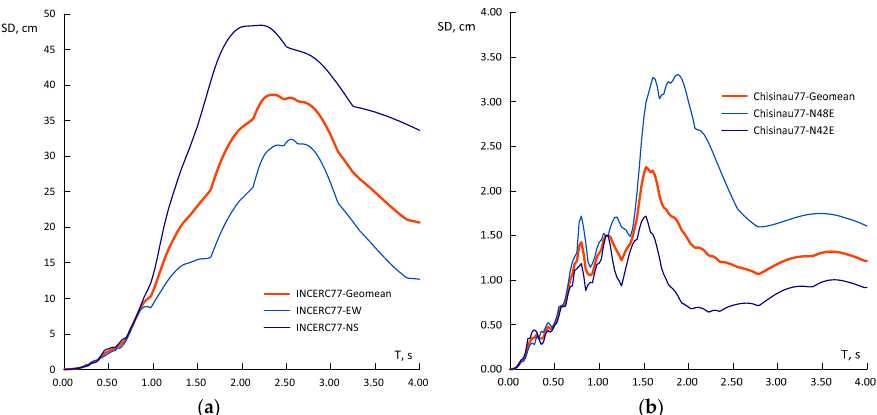
Figure 6. Displacement spectra of 4th of March 1977 earthquake, M W = 7.4, for two stations ( a ) INCERC Bucharest (D epi = 155 km), type C soil; ( b ) Chi ș in ă u (D epi =269 km), type B soil.